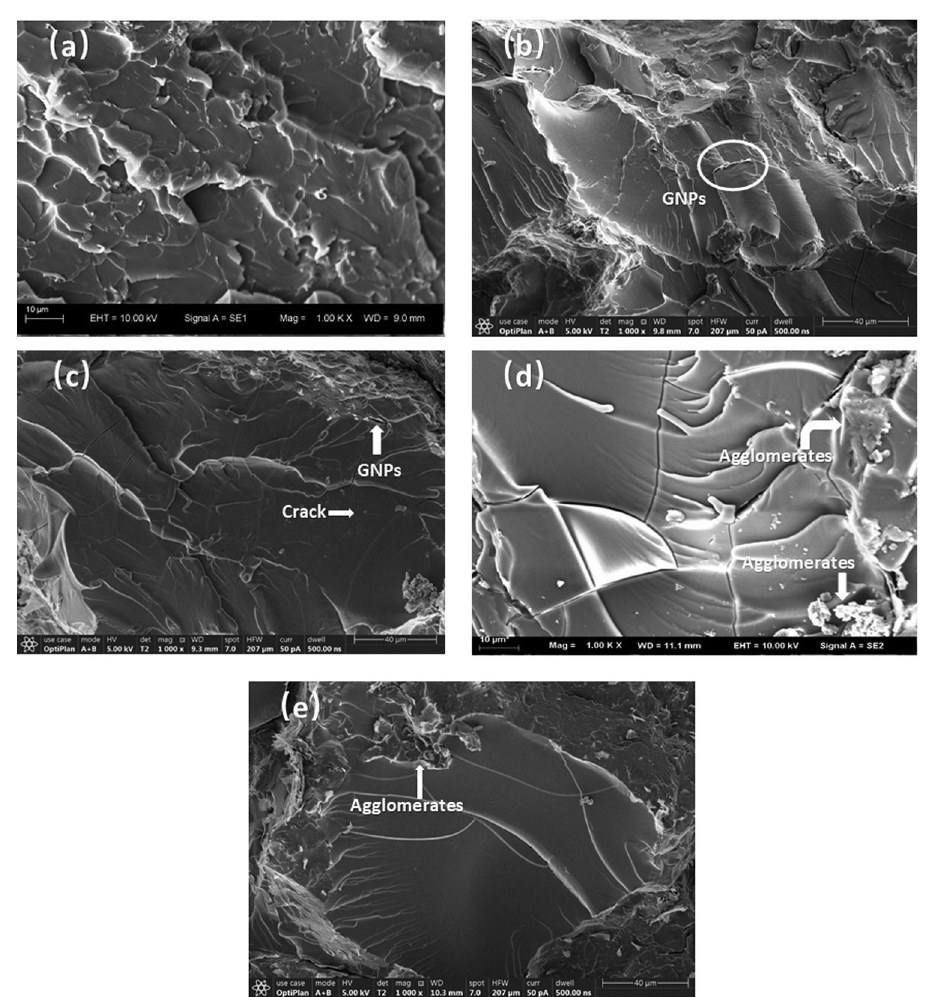
Figure 7: SEM images of impact fracture surfaces of ( a ) polyimine and GNPs composites with di ff erent contents of GNPs: ( b ) 0.5 wt%, ( c ) 1 wt%, ( d ) 1.5 wt%, and ( e ) 2